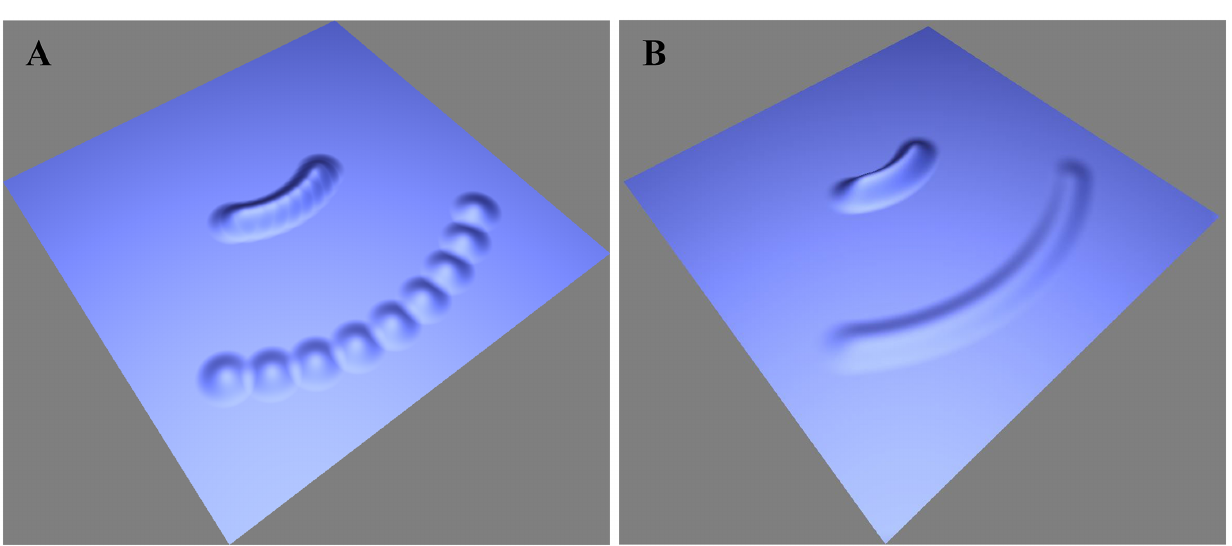
Fig 5. Comparison between wavefronts with and without splitting of particles. (A) The wavefront without splitting after the wave particles travel some distance. (B) The wavefront with splitting after the wave particles travel some distance.